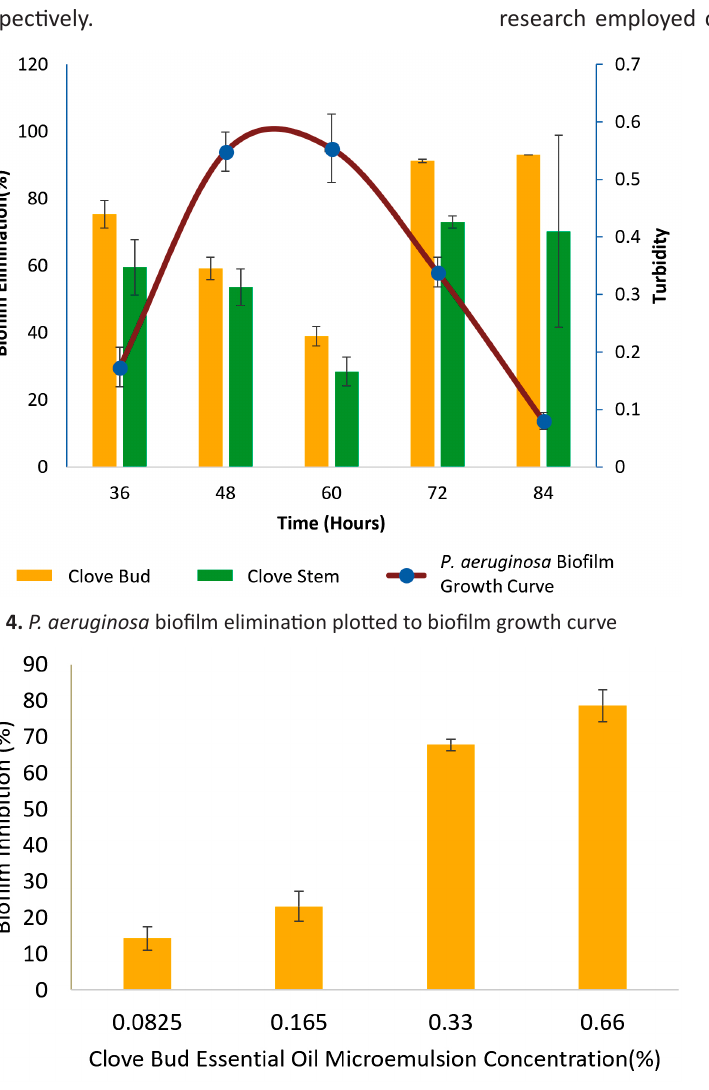
Fig. 5. MBIC assay result of clove bud essential oil microemulsion. MBIC 50% was achieved at 1% of clove